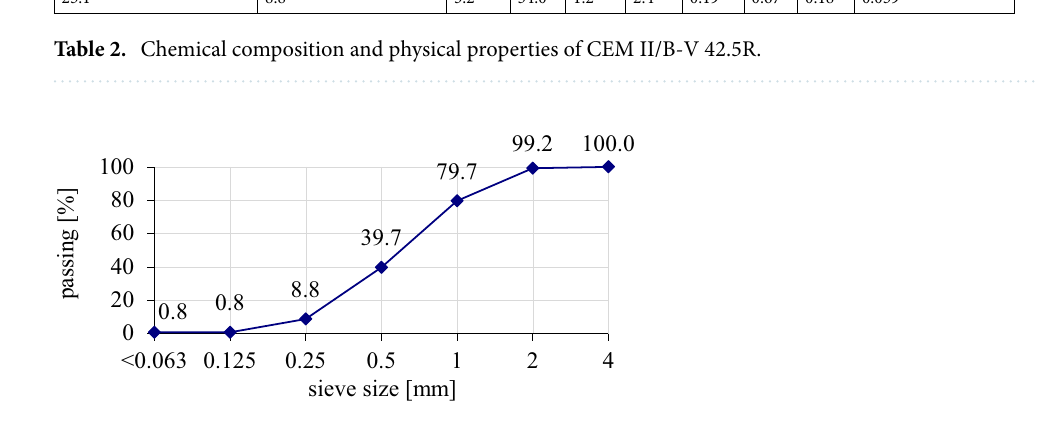
Figure 3. The properties of the grain size of fine aggregate 0–2